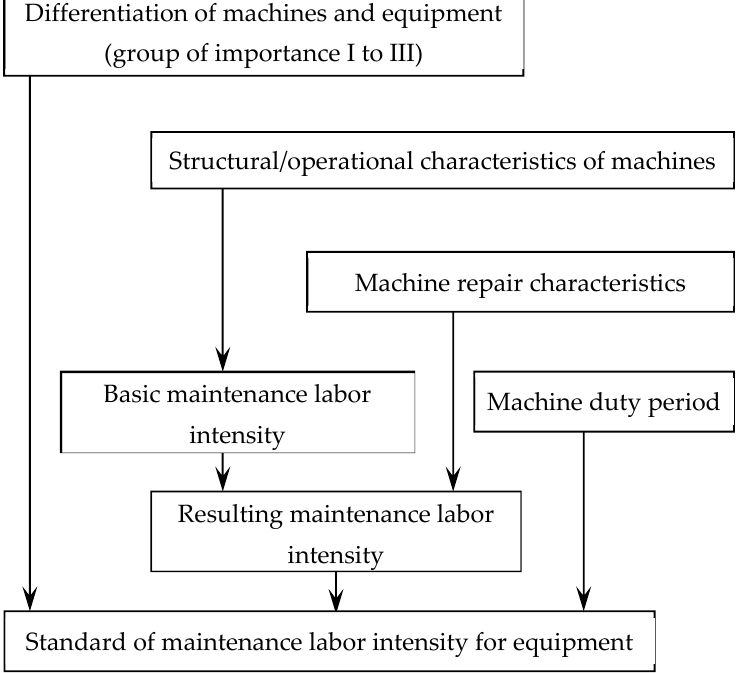
Figure 1. Algorithm for creating the standard for machines and equipment . Source: authors.